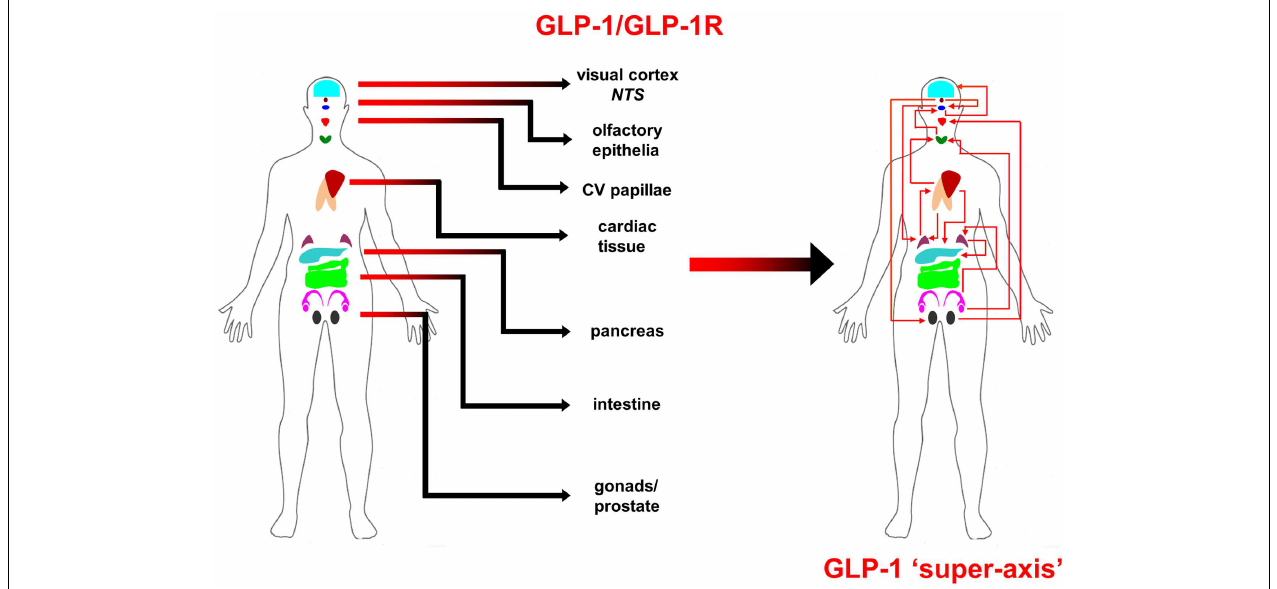
with an easily coordinated mechanism.The physical and hormonal connection between these multiple sites of GPCR functionality therefore can represent a “super-axis” of signaling connectivity that spreads across and over more classically defined tissue–tissue axes, such as the hypothalamic–pituitary– gonadotropic